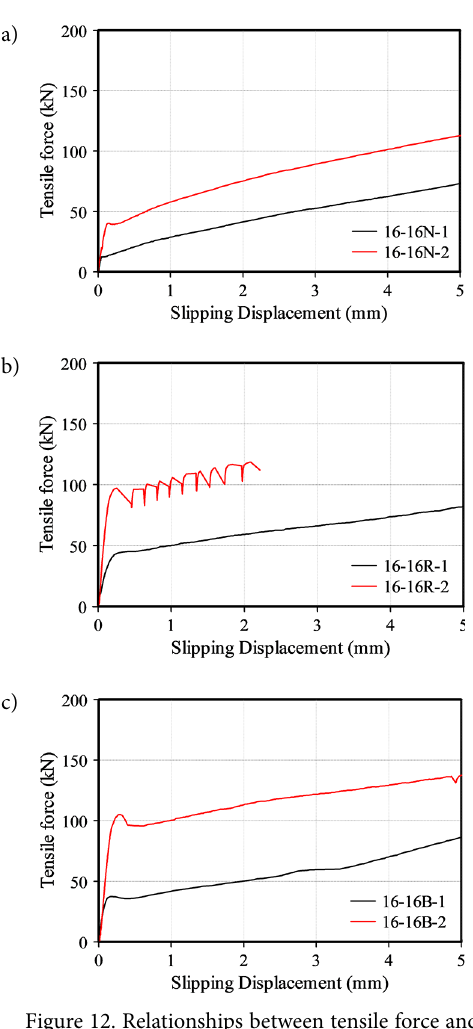
Figure 12. Relationships between tensile force and